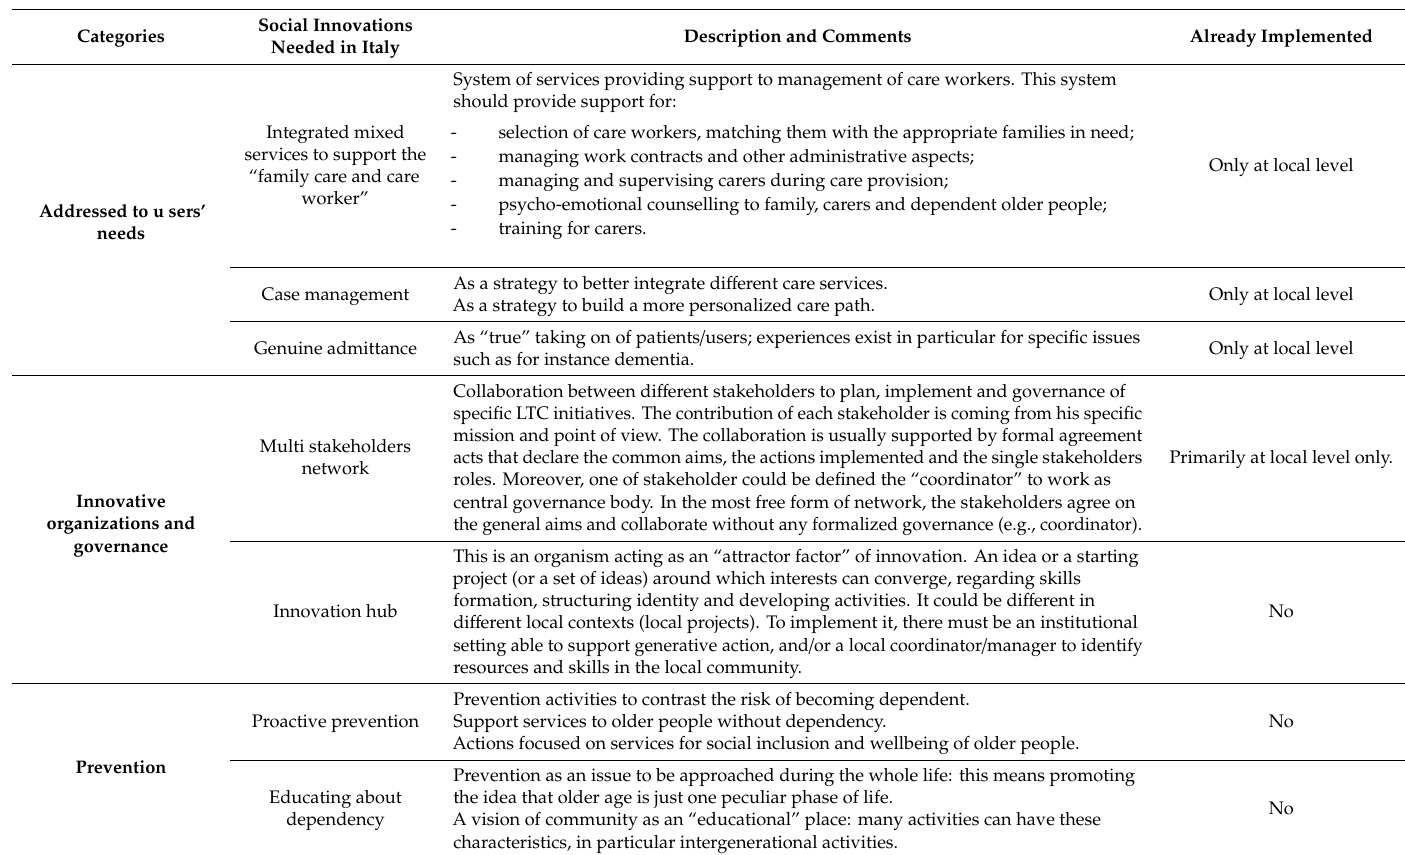
Table 3. Most urgent social innovations needed in